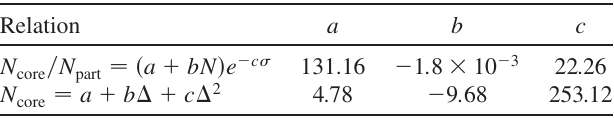
TABLE I. Fit parameters for the scaling laws determined with the numerical simulations.